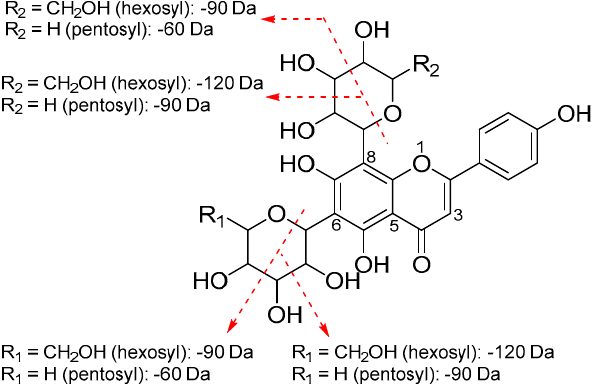
Figure 4. Fragmentation pattern of 6,8-di- C -diglycosylated apigenins.